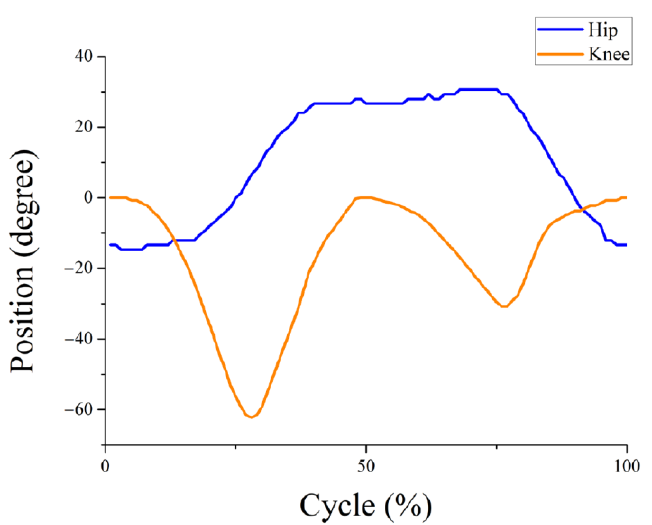
Figure 17. Walking test with the LLRE-II.